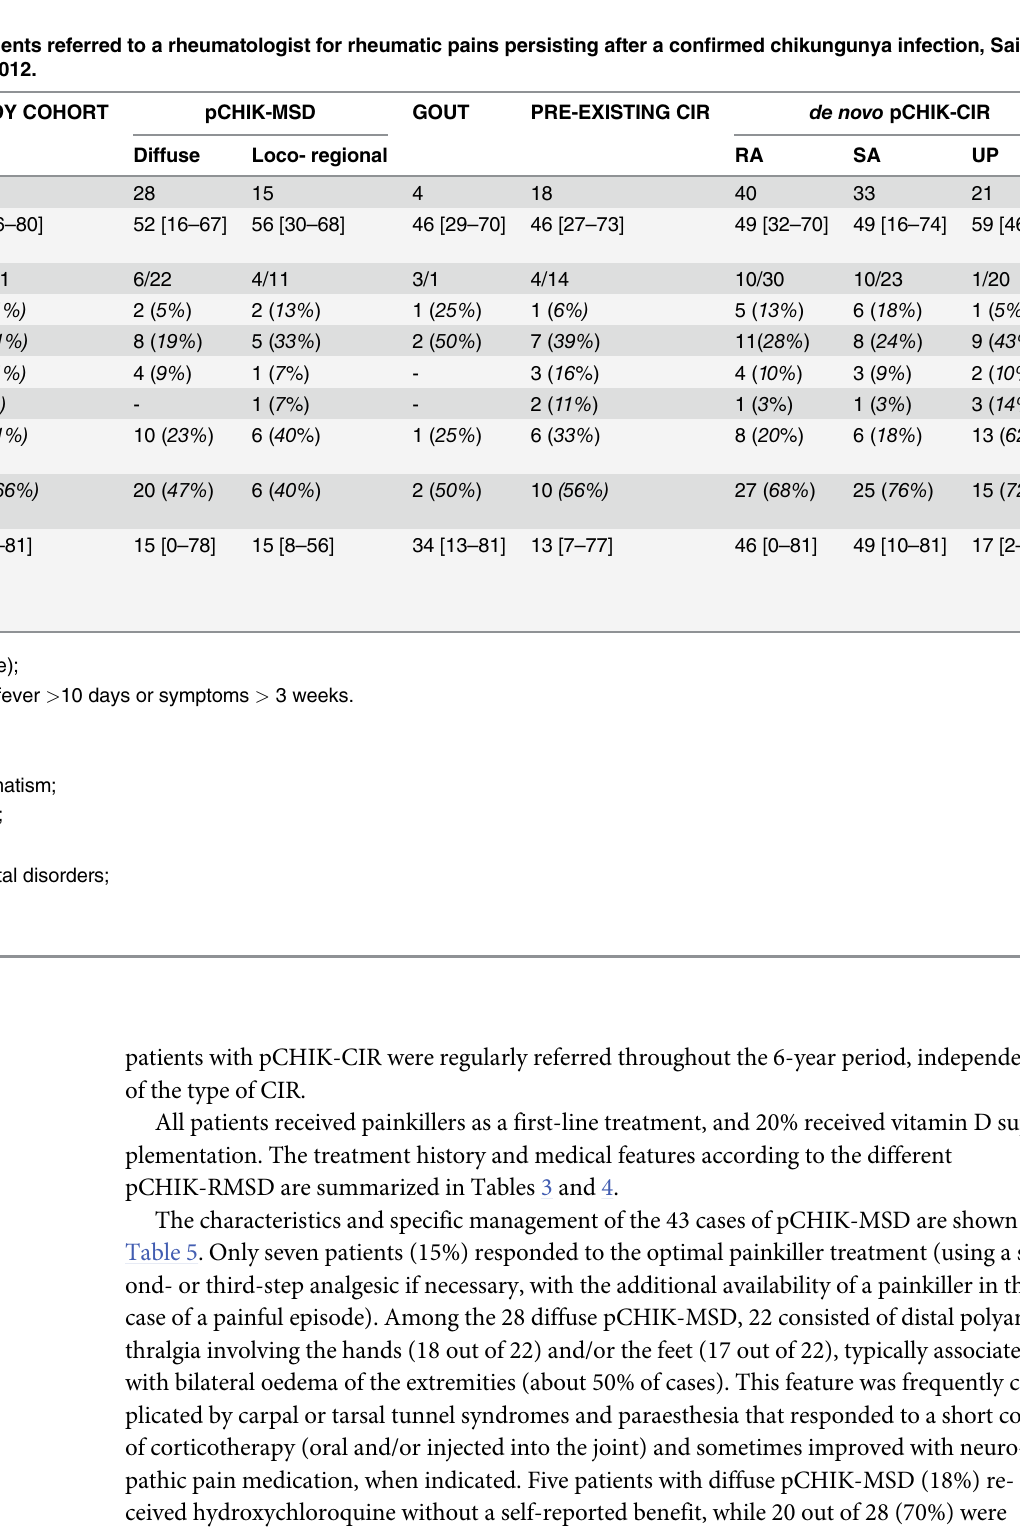
Table 2. Characteristics of patients referred to a rheumatologist for rheumatic pains persisting after a con fi rmed chikungunya infection, Saint Denis, Reunion Island, 2006 – 2012. Variables